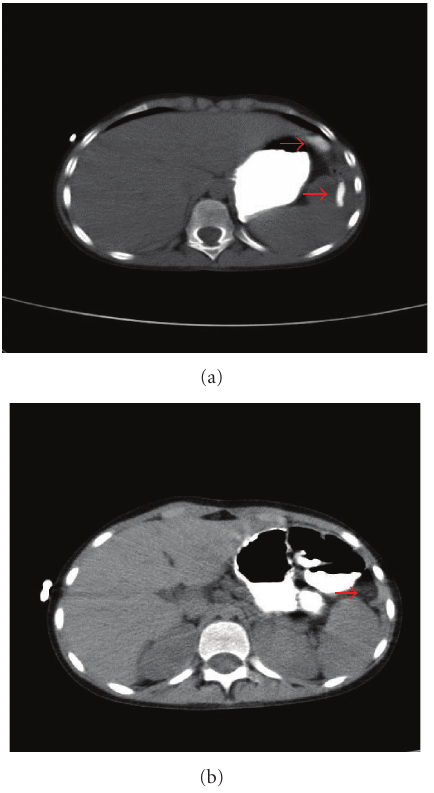
Figure 2: Axial abdominal CT projections (with enteric contrast enhancement) showing a progressive healing of the fistula connect- ing the colonic lumen to the collection before (a) and after (b) the second administration of anti-TNF- α . Figure 2(a). detects the passage of enteric contrast from the colon into the parietal-colonic collection, which is no more visible in Figure